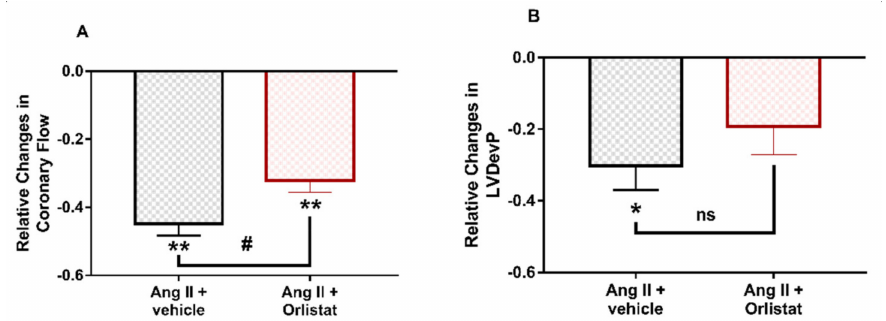
Figure 6. Influence of diacylglycerol-lipase (DAGL) inhibitor Orlistat on the peak effects of an- giotensin II (Ang II) on coronary flow ( A ) and left ventricular developed pressure (LVDevP) ( B ) of isolated rat hearts. Ang II (10 − 7 M) was administered repetitively to the perfusate. The presented data were recorded during the second infusion period when Ang II was infused either in the presence of DAGL inhibitor Orlistat (10 − 5 M) or its vehicle and are expressed as relative values compared to pre-infusion control data. Mean ± SEM; n = 4 & 6; * p < 0.05 and ** p < 0.01 vs. control (pre-infusion value) paired t -test; # p < 0.05 and ns: non-significant vs. Ang II +vehicle; t